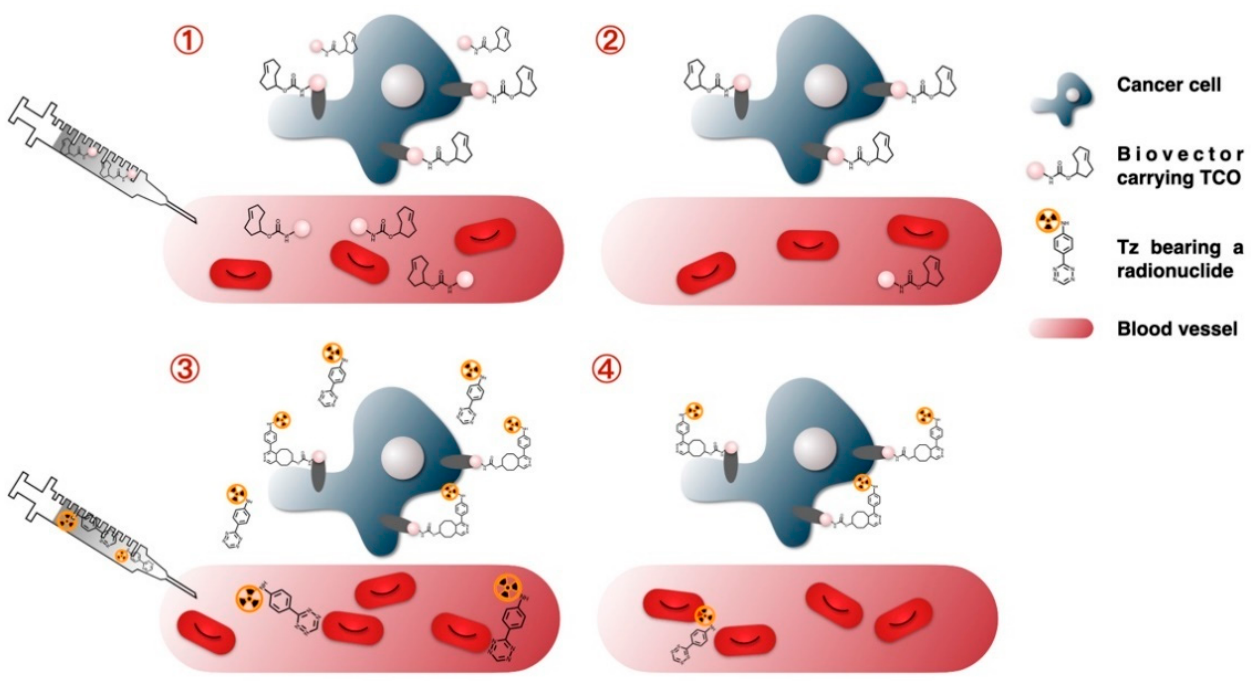
Figure 1. Illustration of the four basic steps of the pretargeting approach.